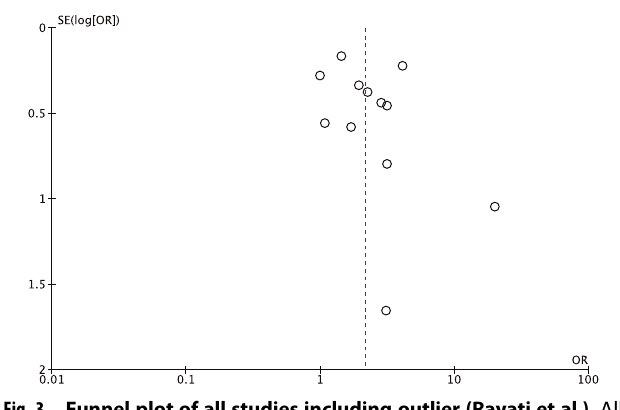
Fig. 3 Funnel plot of all studies including outlier (Rayati et al.). All studies except one outlier fall within the funnel (shown in Fig. 4).